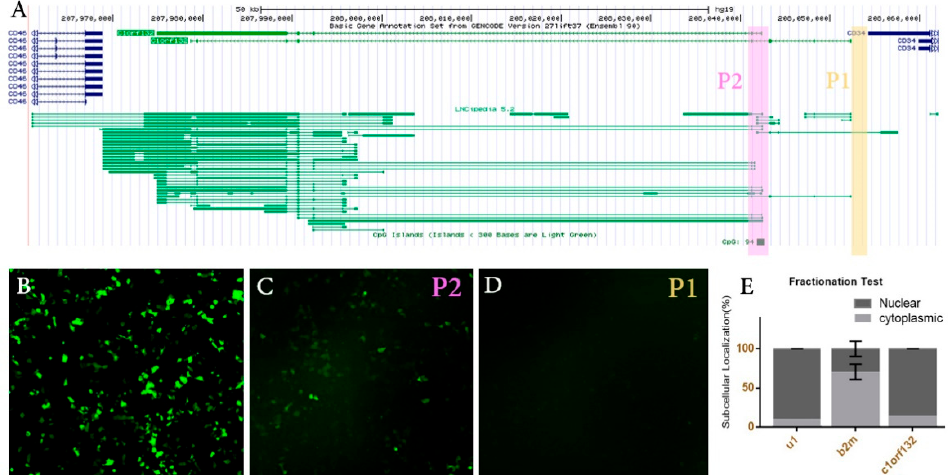
Figure 4. C1orf132 has at least two active promoters. ( A ) The bioinformatics data suggested the existence of two additional potential promoters (p1 and p2), in addition to its conventional promoter. The predicted sequences correlated to the putative promoters were cloned into a promoterless pEGFP-1 vector. MCF7 cells were transfected with: ( B ) pEGFP-C1 vector as a positive control, ( C ) pEGFP-1-p2 for the putative p2 promoter region, ( D ) pEGFP-1-p1 for the putative p1 promoter region. Note that only the p2 region exhibited promoter activity (100 × magnification). ( E ) The subcellular localization of C1orf132 following nuclear and cytoplasmic subcellular fractionation. C1orf132 is primarily localized within the nuclear compartment. U1 and B2M were used as markers for nuclear and cytoplasmic compartments, respectively.